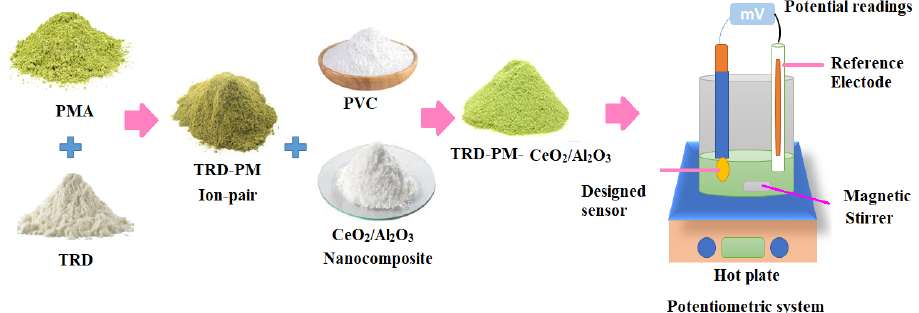
Figure 2. Preparation of TRD-PM-CeO 2 /Al 2 O 3 electroactive complex and the potentiometric system employed for TRD determination.